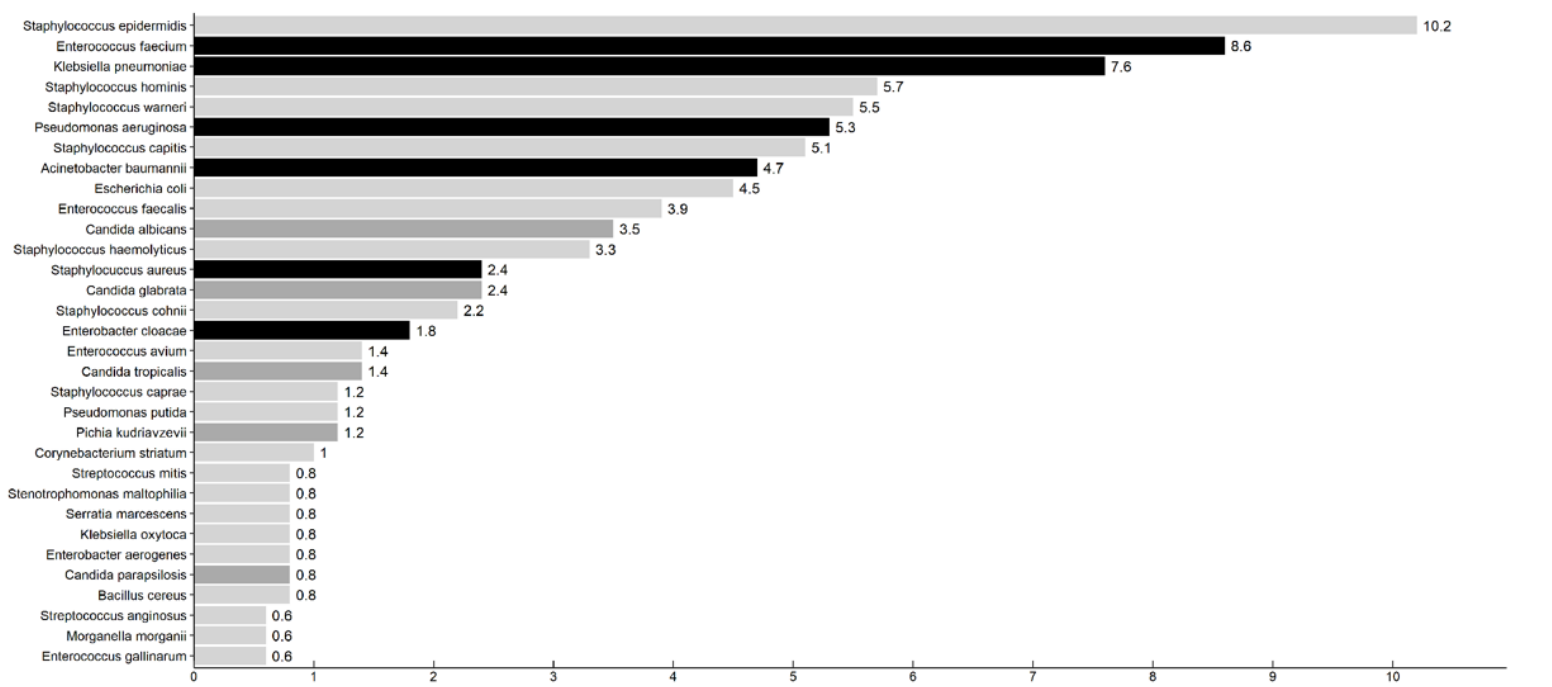
Figure 2. Distribution of pathogens in preservation fluid. Pathogens with a frequency of less than or equal to 0.5 percent are not shown.